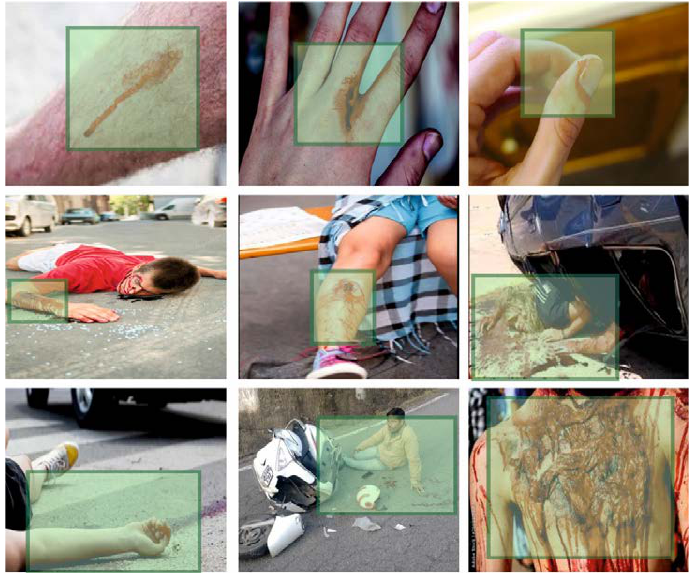
Figure 3. ROI Extraction.